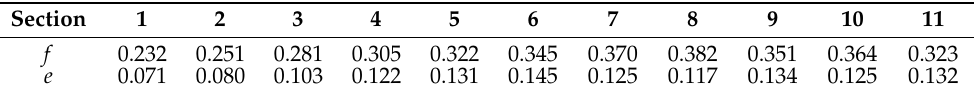
Table 2. Calculation results for the induction coefficient of each section.